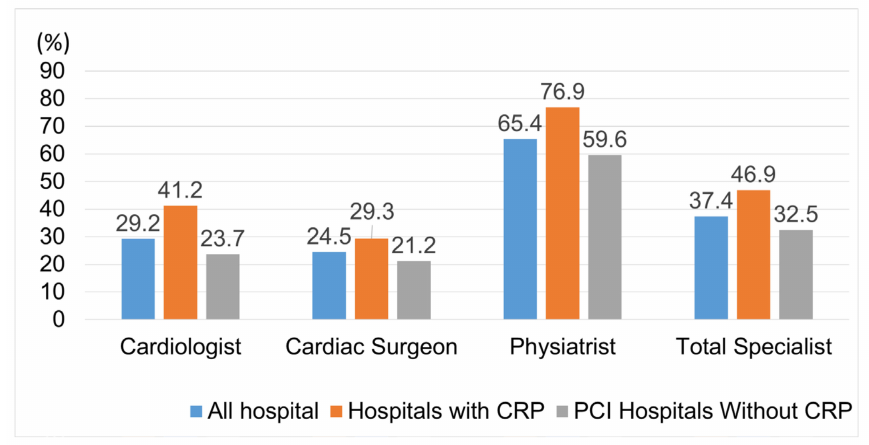
Figure 2. The response rates according to specialties and the presence or absence of cardiac rehabili- tation programs (CRP).